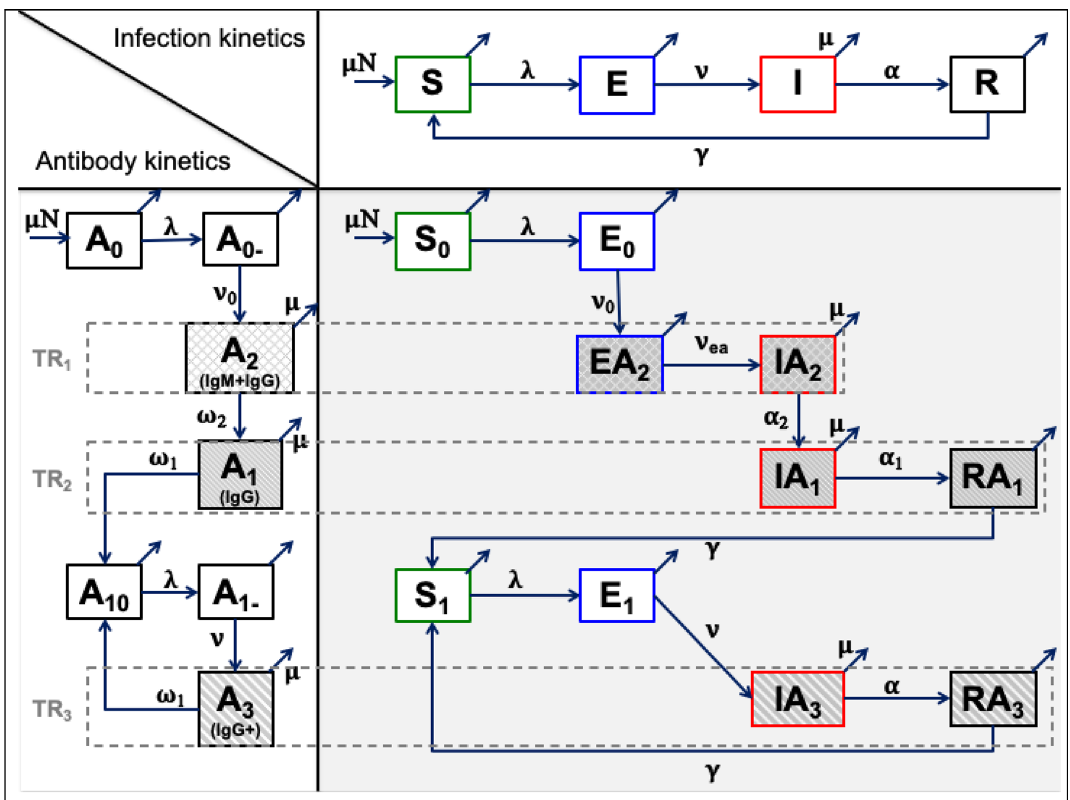
Figure 1. Kinetic scheme of the combined (right bottom) infection (top) and antibody (left bottom) dynamics. Description of population and parameters are provided in the main text and Table 1. TR i stands for “Test Result” of a diagnostic test. Arrows tilted up correspond to the natural mortality rate μ (identical for all arrows but just indicated for